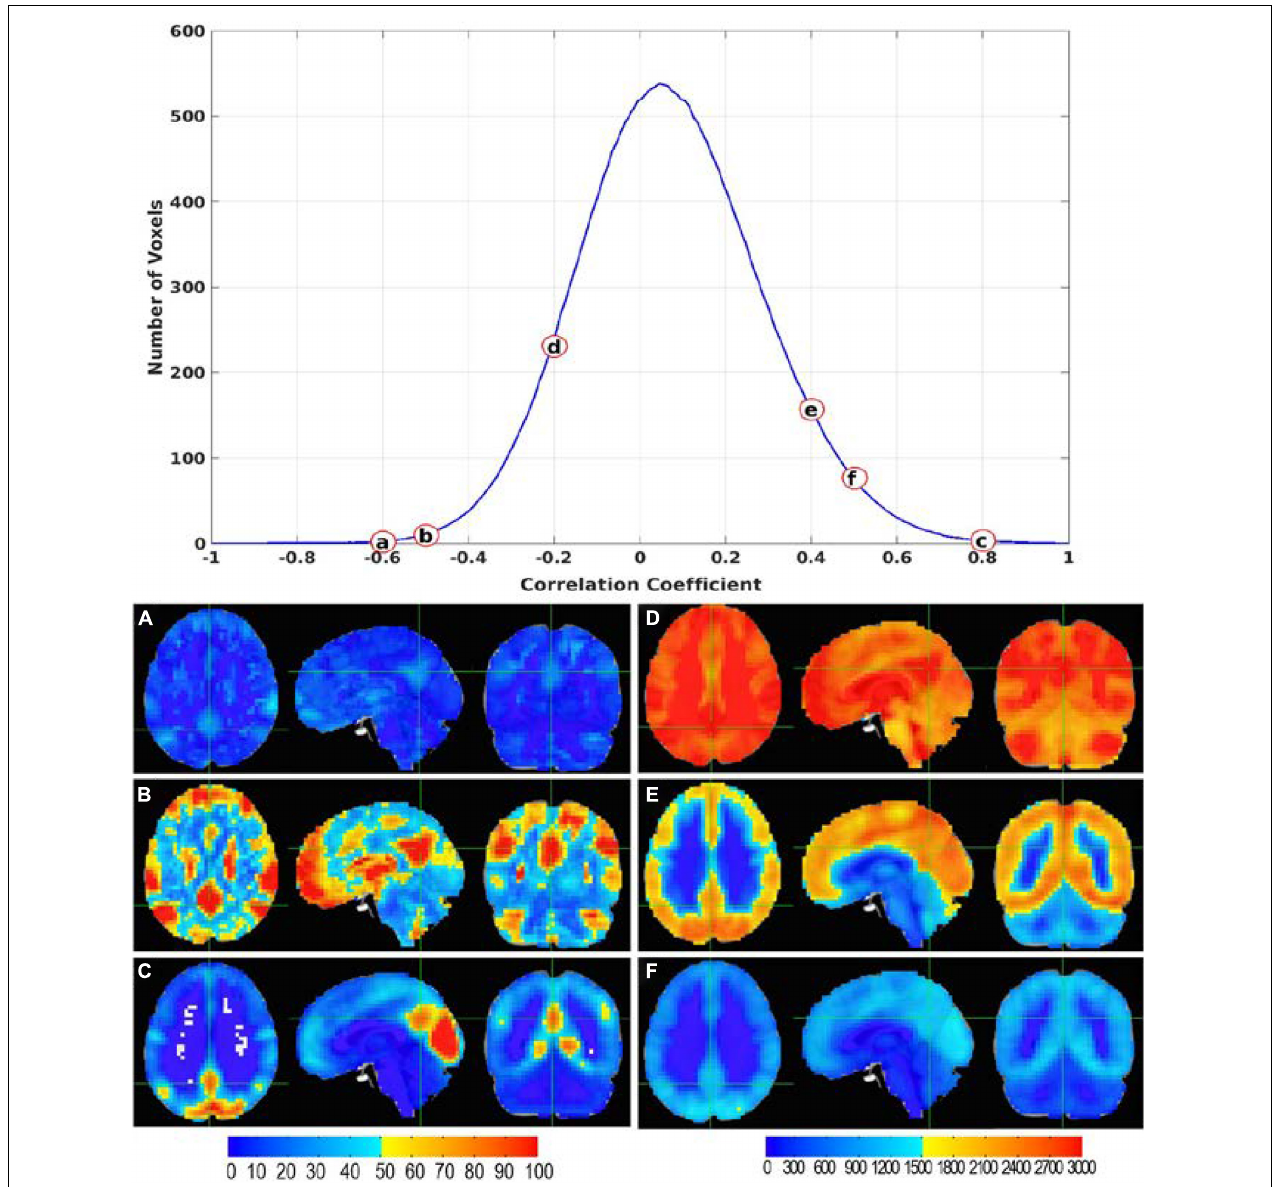
FIGURE 3 | The average CC histogram of the cohort for a seed voxel in the posterior cingulate cortex (PCC) as indicated by the green cross. Selecting different threshold values along the histogram allows us to examine the functional connection networks of different strengths (A–F) associated with the seed voxel in the